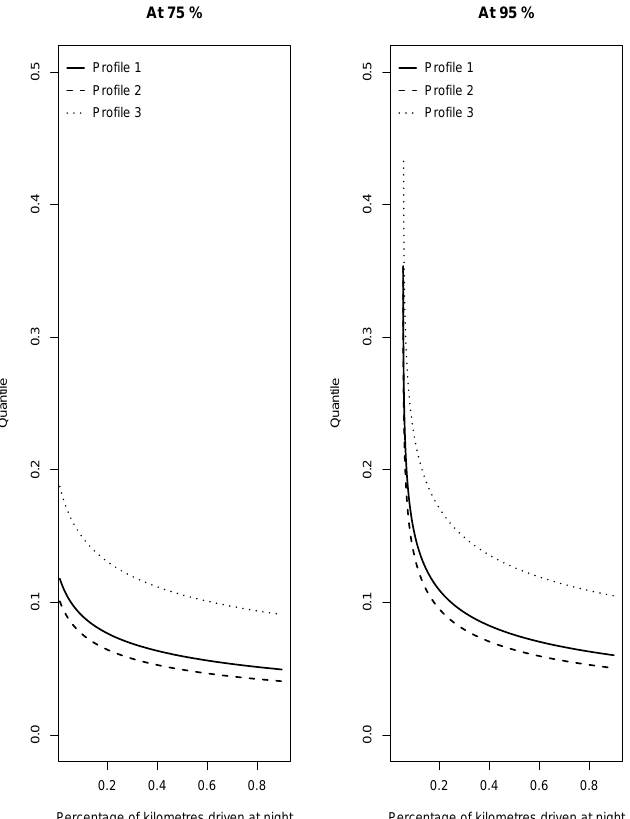
Figure 2. Quantiles of percentage of kilometres driven over the speed limit ( Y 1 ) for each driver profile given the values of percentage of kilometres driven at night ( Y 2 ), ( left ) 75% level and ( right ) 95%